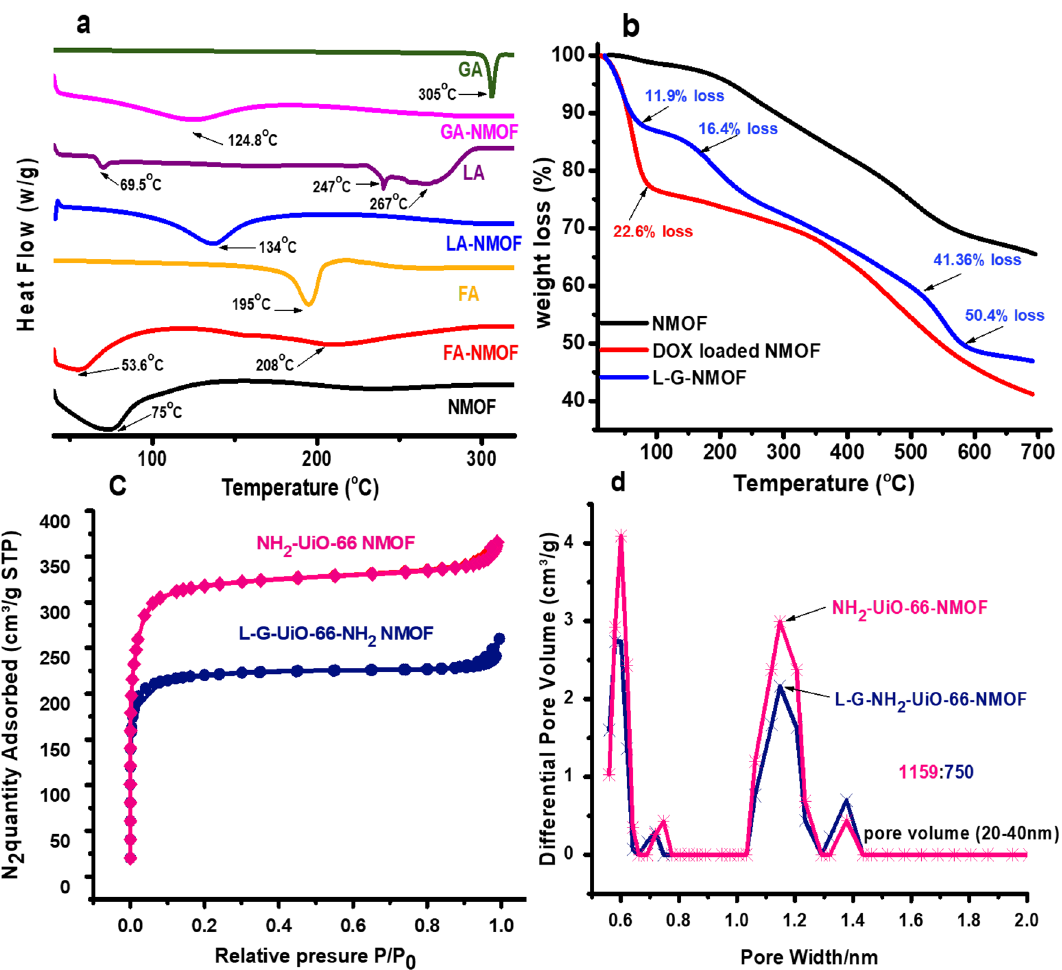
Figure 3. ( a ) DSC measurement for NMOF, mono-ligated NMOF, and the free FA, LA and GA ligand, ( b ) TGA analysis for NMOF, LA-GA-NMOF and DOX-loaded NMOF, ( c ) N 2 adsorption and desorption isotherms at 77 K for NMOF and LA-GA-MOF, and ( d ) PSD for NMOF and